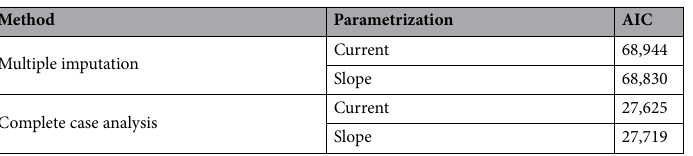
Table 2. Comparison of the joint model with the current value and slope parameterization under multiple imputation and complete case analysis missing handling method for T2DM patients.